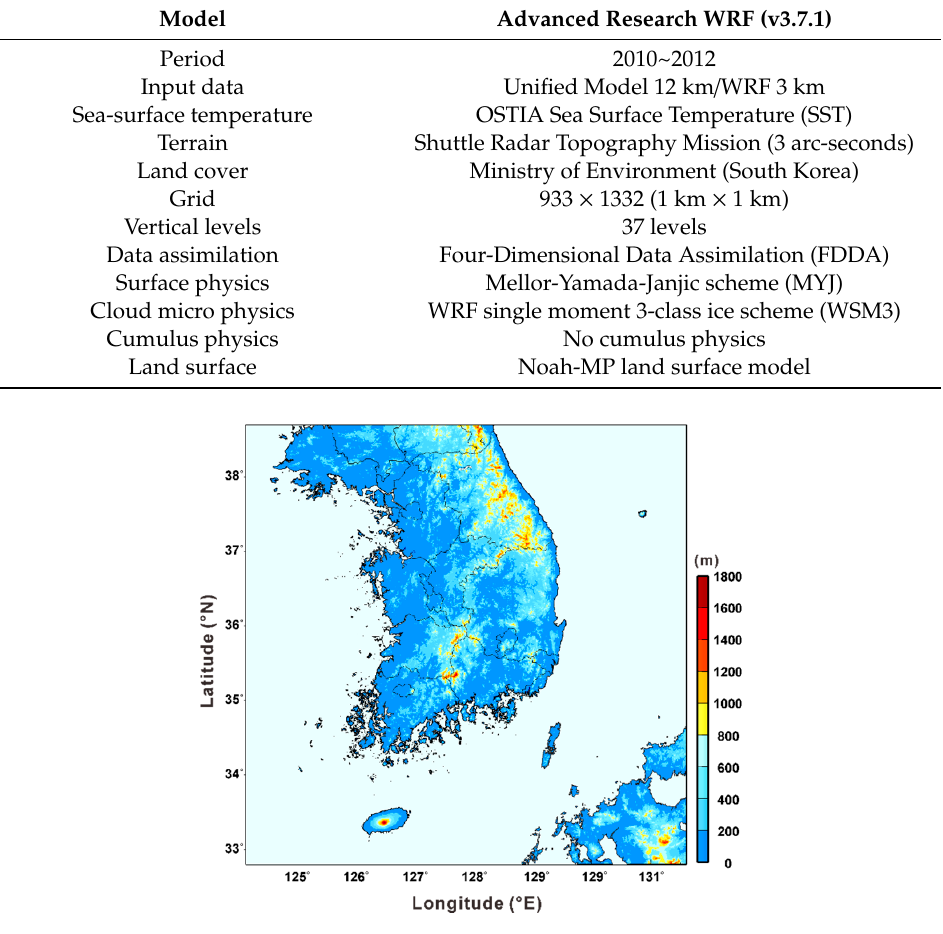
Figure 1. Terrain elevation of the analysis domain (South Korea).